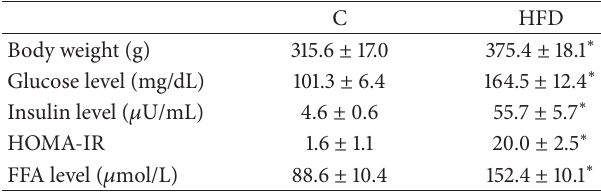
C: control group. HFD: group fed with high fat diet. Results are based on 8 independent preparations for each experimental treatment (means ± SD). ∗ 𝑝 < 0.05 compared with C group.